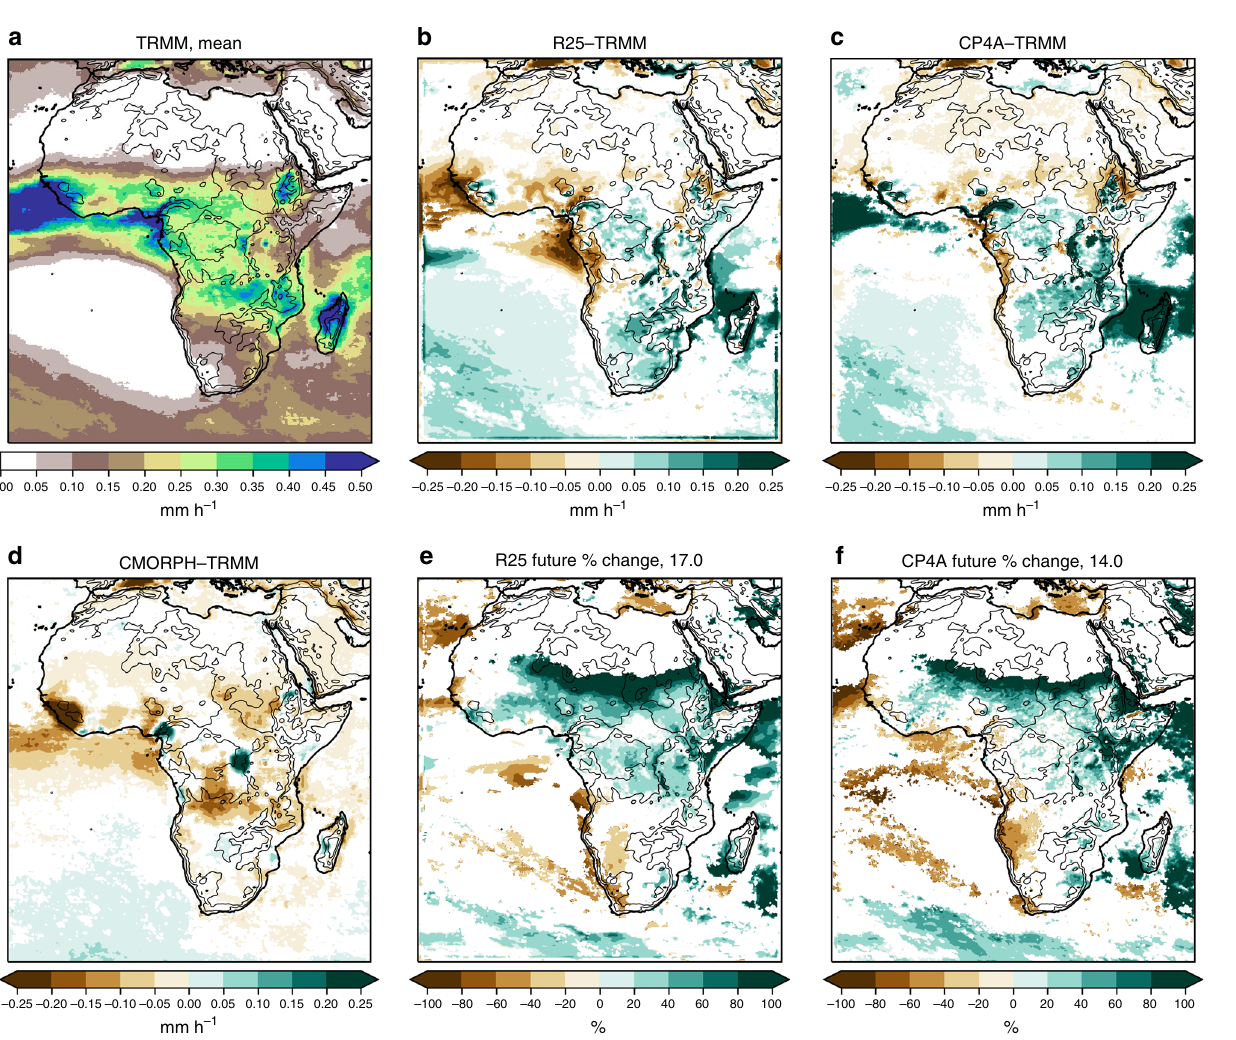
Fig. 2 Wet season mean precipitation. a TRMM observations, differences with respect to TRMM for b the R25 model, c CP4A model and d CMORPH observations, and percentage differences between 2100 and present day for e the R25 model and f CP4A model. The median of future percentage changes across Africa (land points only) is indicated in e , f . Dataset differences and future changes are masked in white, where differences are not signi fi cant at the 5% level compared with year-to-year variability. The wet season is the 3-month period with the highest mean precipitation in TRMM, de fi ned on a grid- point basis. The black lines indicate the 500 -, 1000 -, 2000-, 3000 - and 4000 -m height